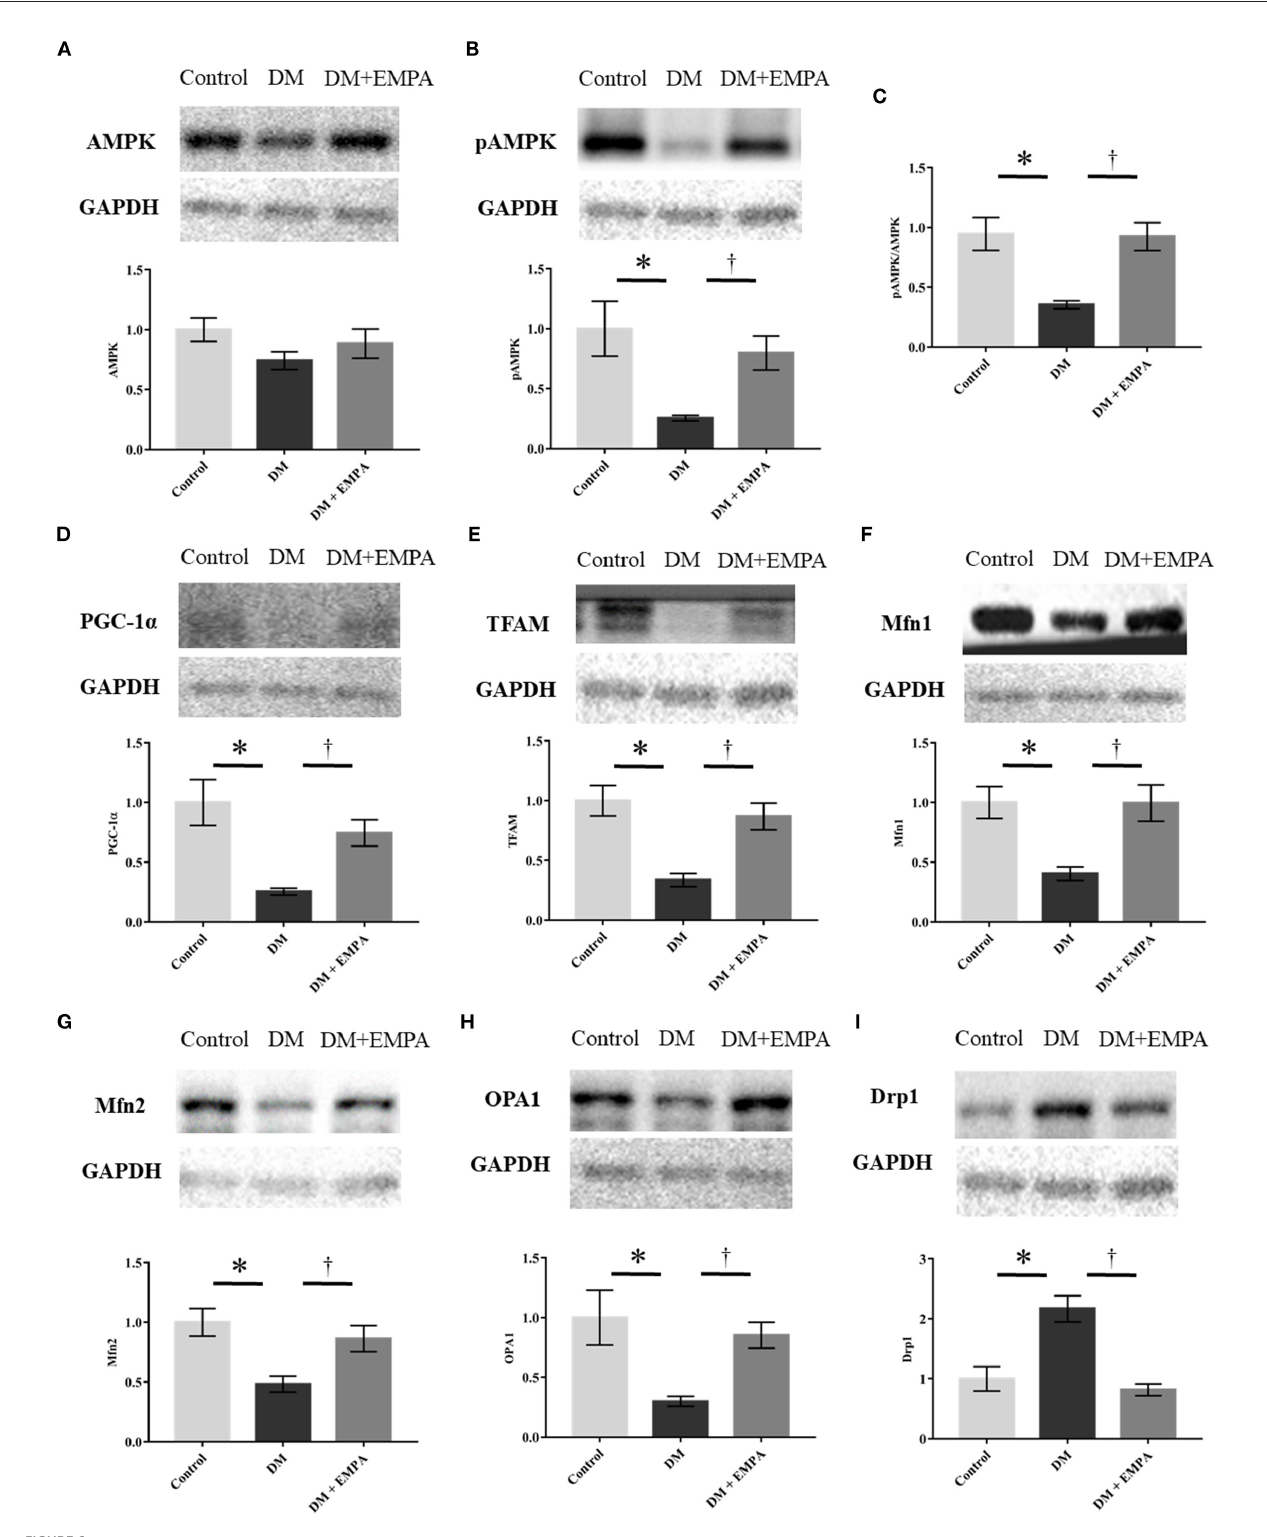
FIGURE6 Western blotting analyses regarding mitochondrial biogenesis, fission, and fusion. (A, B, D–I) Representative western blot results and analyses for the protein expression of AMPK, phosphorylated AMPK, PGC1- α , TFAM, Mfn1, Mfn2, OPA1, and Drp1. (C) The value expressed is the ratio of pAMPK to AMPK. GAPDH was used as an endogenous control. Data are expressed as mean ± SE ( n = 6 per group). * p < 0.05: vs. Control, † p < 0.05: vs. DM (One-way repeated ANOVA with post hoc Tukey’s multiple-comparison test). pAMPK, phosphorylated AMP-activated protein kinase; PGC-1 α , peroxisome proliferator-activated receptor γ coactivator-1 α ; Mfn, mitofusin; OPA1, optic atrophy 1; Drp1, dynamin-related protein 1; GAPDH, glyceraldehyde 3-phosphate dehydrogenase; DM, diabetes; EMPA,